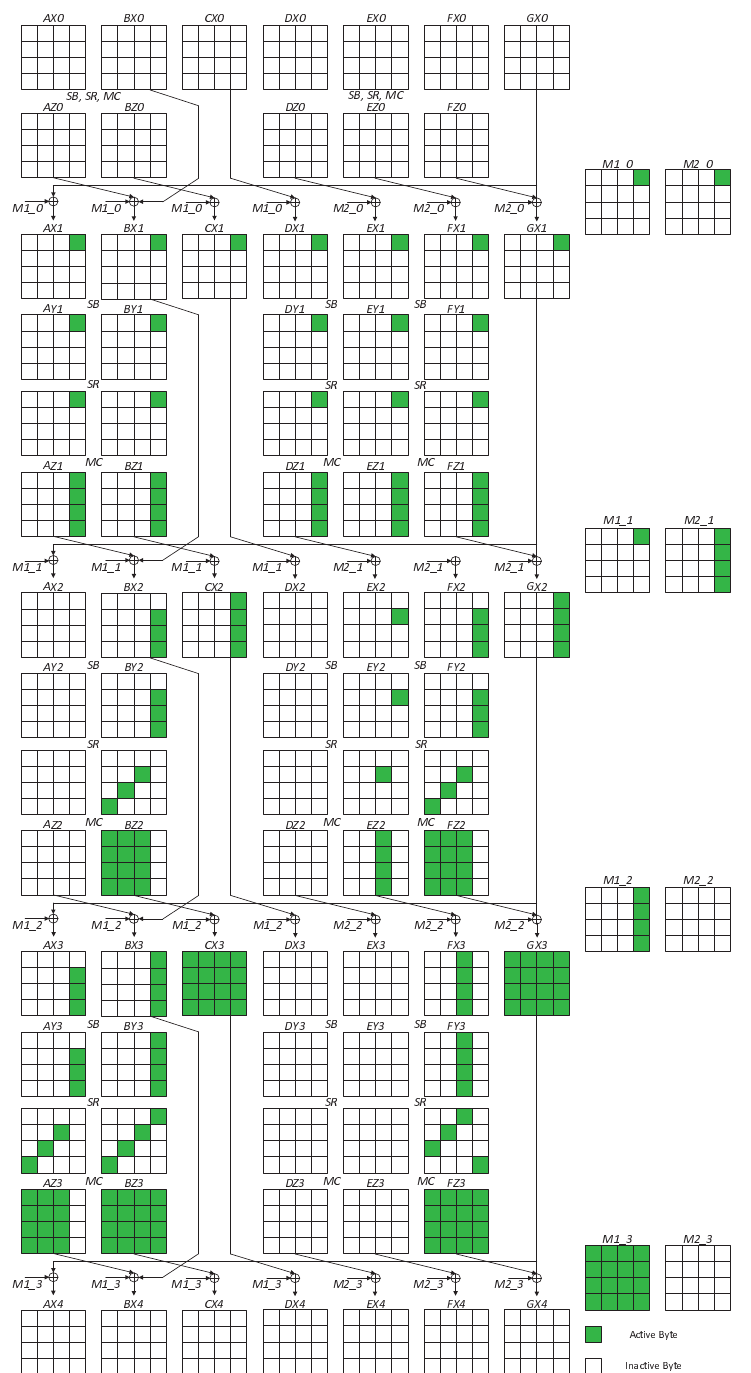
Figure 7: Invalid differential characteristic for C5 with 23 active